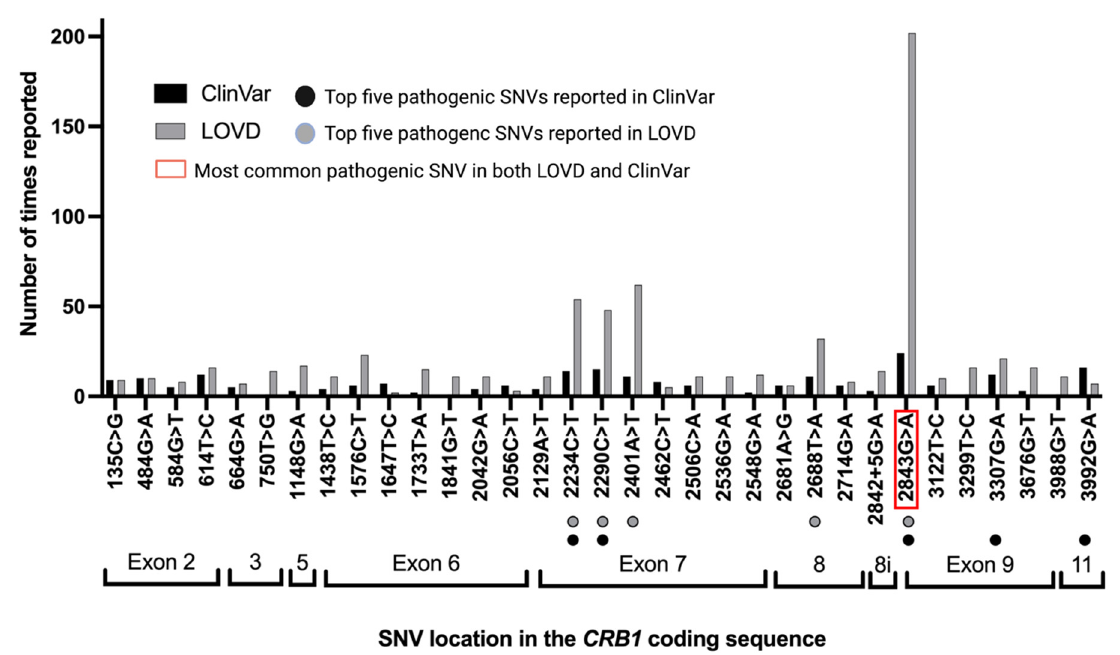
Figure 5. Most commonly reported CRB1 mutations by frequency. The most frequently reported mutation in both the LOVD and ClinVar databases was c.2843G>A. Furthermore, c.2234C>T and c.2290C>T were among the top five most commonly reported pathogenic SNVs in both datasets. Of the pictured mutations, 70% would be targetable by a BE, with an ABE alone being able to target 36% of these mutations.